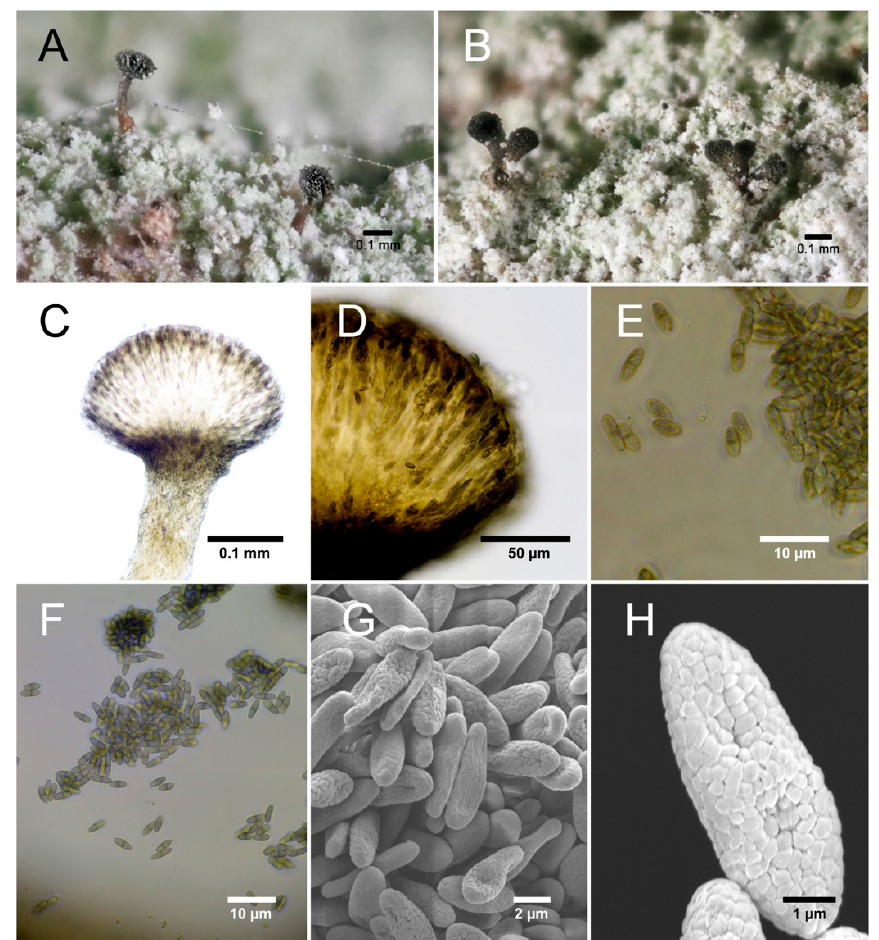
Figure 2. Chaenothecopsis kilimanjaroensis ; ( A ) Well-stalked apothecia with brown stalks ( B ) aggregated apothecia ( C ); section of apothecium with pale stalk; ( D ) dark brown, well-developed excipulum; ( E ) spores with a faint ornamentation as barely visible under the light microscope; ( F ) spores; ( G ) spores, SEM; ( H ) verrucose spore ornamentation, Scanning Electron Microscopy (SEM ) . Holotype : Tanzania , Arusha, Monduli forest reserve, 3°14’47.71” S 36°29’22.96” E, 2456 m on trunks of Nuxia congesta , 16 August 2018, Temu 337 (UPS—holotype; DNA-extraction SGT337, MycoBank no.: MB